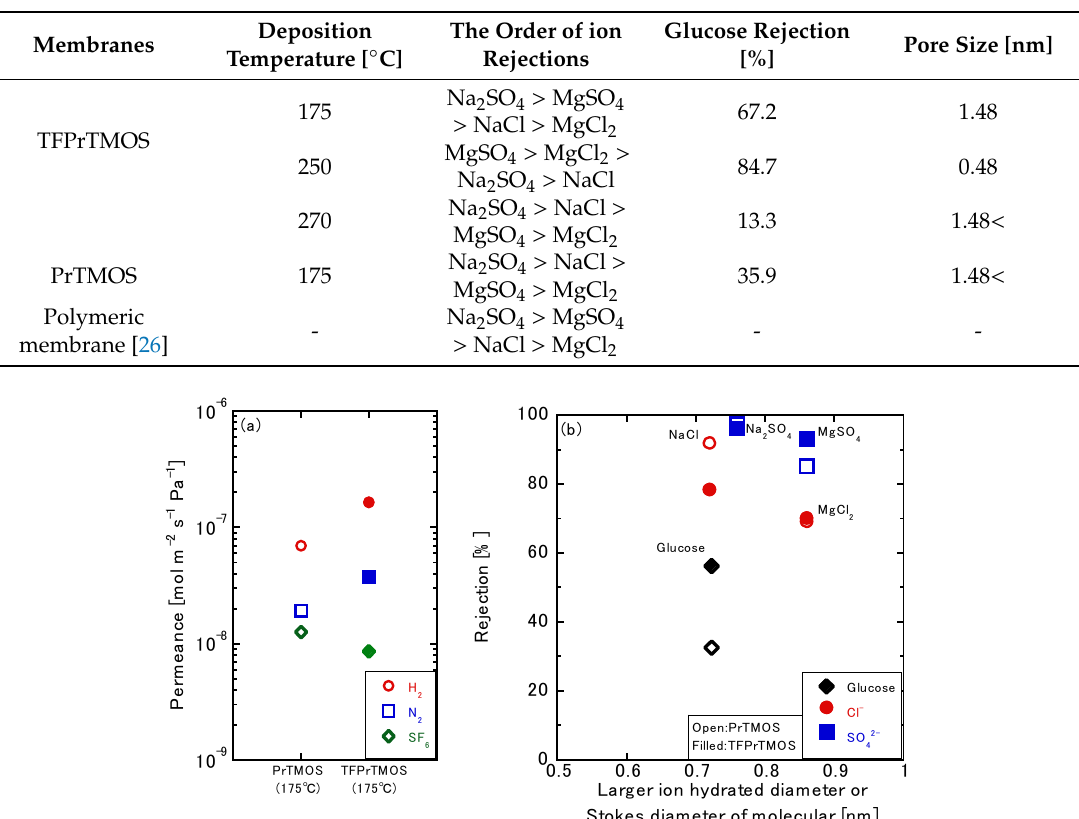
Figure 9. ( a ) The gas permeance and ( b ) the ion rejection through PrTMOS-derived and TFPrTMOS-derived membrane deposited at 175 °C.